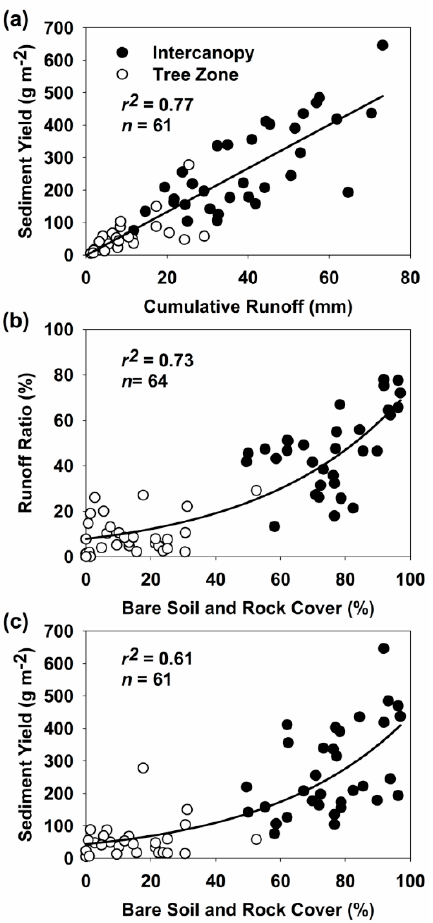
Figure 5. Sediment yield versus cumulative runoff ( a ), the runoff ratio versus bare ground (bare soil and rock, ( b )), and sediment yield versus bare ground ( c ) for rainfall simulation experiments (102 mm h − 1 , 45 min, 13 m 2 plots) in intercanopy areas (Intercanopy) between trees and in tree canopy areas (Tree Zones) of western juniper ( J. occidentalis Hook.), Utah juniper ( J. osteosperma [Torr.] Little), and singleleaf pinyon ( P. monophylla Torr. & Frém.)-Utah juniper woodlands in the Great Basin. The graphs clearly depict that sediment delivery from these systems is well correlated to the amount of runoff generated and that both runoff and sediment yield are well correlated with percent bare ground. Data from Pierson et al. [27,46] and Williams et al. [28].